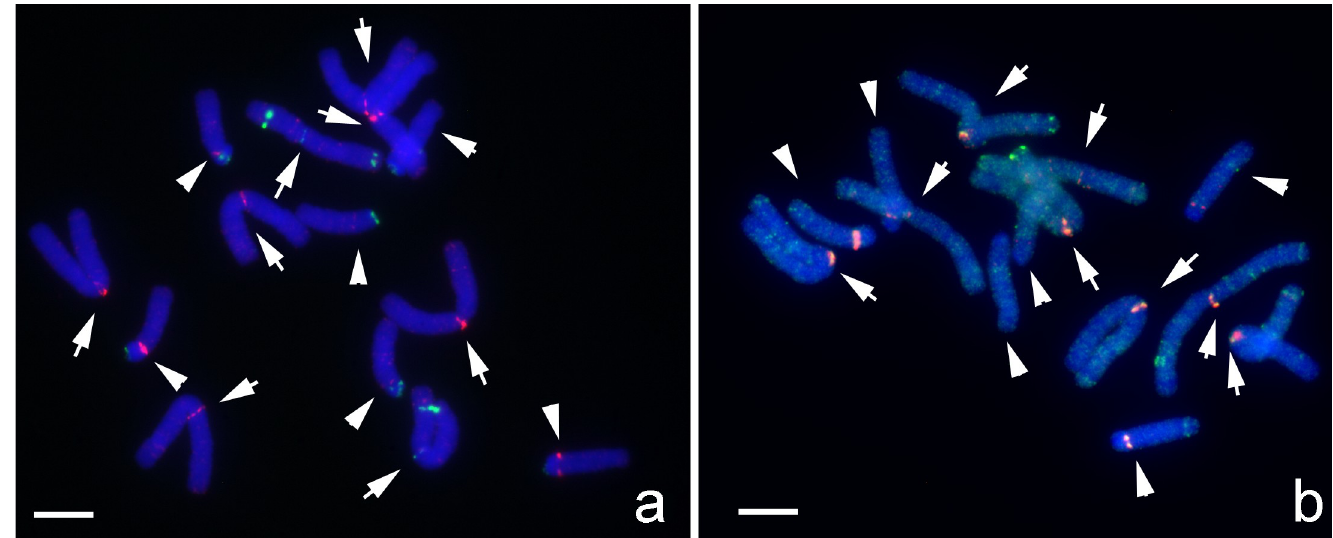
Fig 10. FISH mapping LaCenIP-1R-E1 specifically at the centromeric region on M-type chromosomes of L . aurea . (Scale bar = 10 μ m). The fluorescent signals of LaCenIP-1R-E1 probes are more specifically present at centromeric regions of M-type chromosomes (arrows) in comparison with the LaCenIP-1 probe. Note the major signals of both probes are not present at distal end of T-type chromosomes (arrowheads). (a) 5S rDNA (green), LaCenIP-1R-E1 (red); (b) LaCenIP-1R-E1 (red), LaCenIP-1